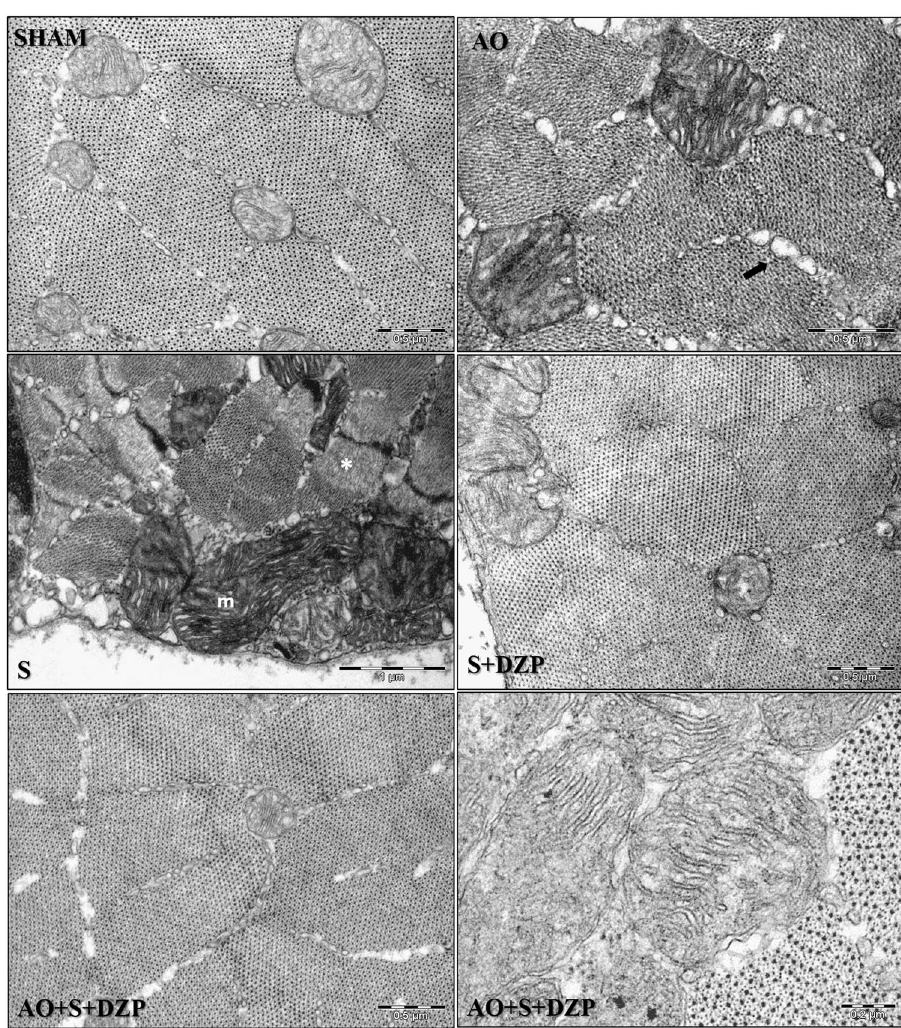
Figure 5. Effects of stress, occlusal instability and diazepam treatment on ultrastructural morphology of medial pterygoid muscle. Transmission Electron Microscopy (TEM) images of right MPM of control animals (SHAM), Altered Occlusion rats (AO), chronic stress group(S), stressed group treated with diazepam (S + DZP) and Altered Occlusion and stress treated with diazepam (AO + S + DZP). AO group showed dilated sarcoplasmic reticulum cisternae with irregular contours (arrow). The S group indicated myofibrils containing amorphous material ( * ) and altered morphology mitochondria (m). SHAM, S + DZP and AO + S + DZP groups showed muscle fibers with well- preserved structures, such as myofibrils, mitochondrial shape and content, and sarcoplasmic reticulum cisternae without apparent expansion. Scale bars represent: SHAM (0.5 µ m), AO (0.5 µ m), S (1 µ m), S + DZP (0.5 µ m), AO + S + DZP (0.5 µ m) and AO + S + DZP (2 µ